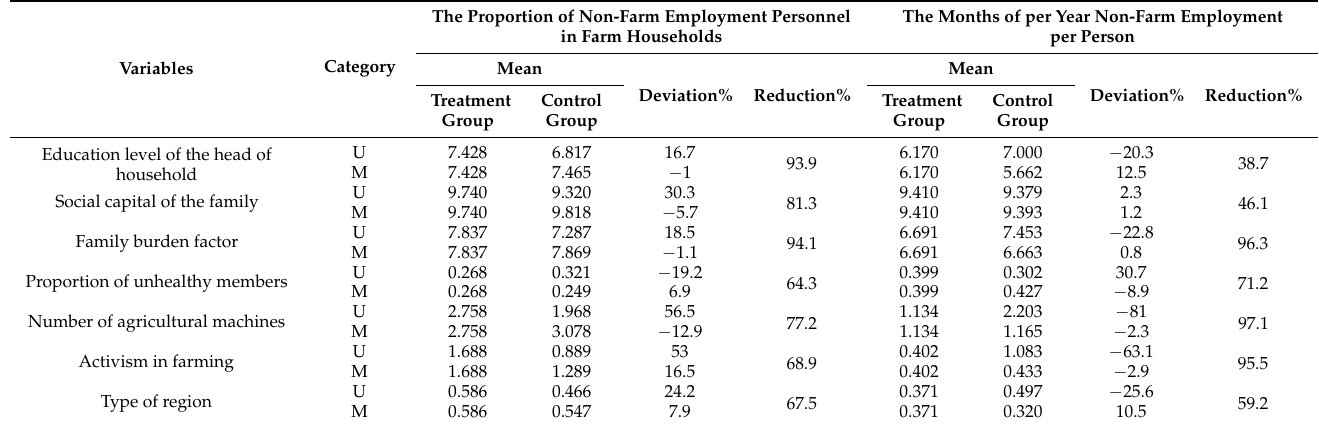
Table 2. Results of the balance test for propensity score